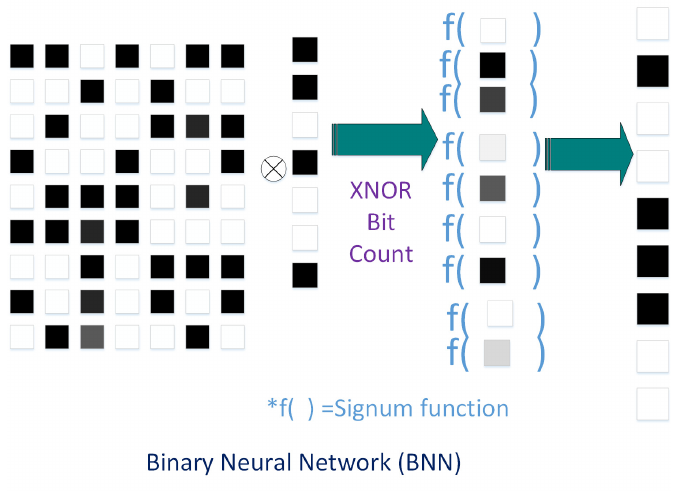
Figure 2. BNNs use binary weights and